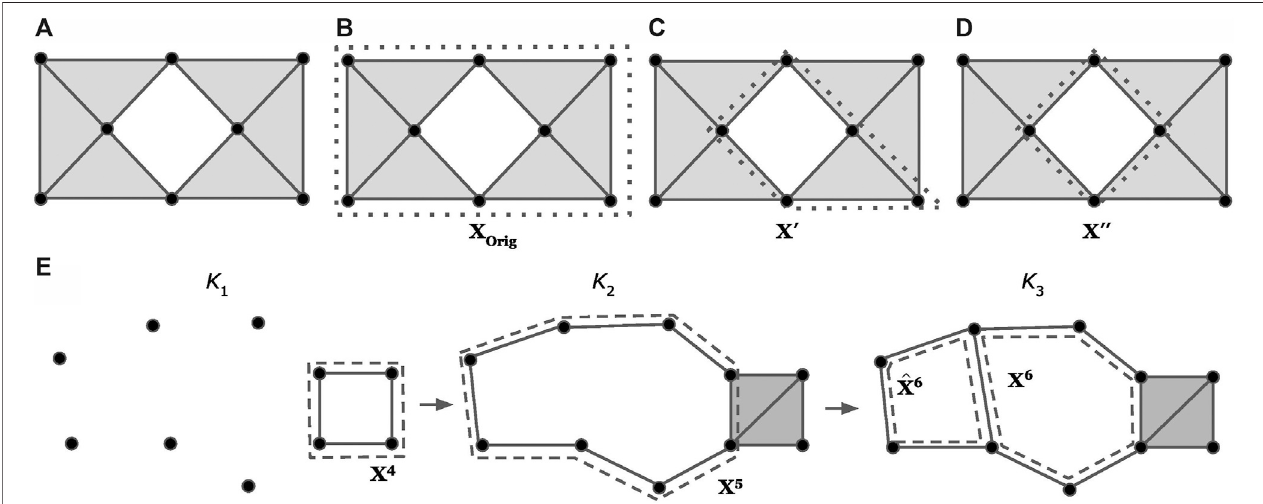
FIGURE 3 | Examples of optimizing a cycle representative (using the notion of minimizing edges) within the same homology class (A-D) and using a basis of cycle representatives (E) , modi fi ed examples adapted from (Escolar and Hiraoka, 2016; Obayashi, 2018). The dotted lines represent a cycle representative for the enclosed “ hole. ” Intuitively, we consider x ′′ in (D) as the optimal cycle representative since it consists of the smallest number of edges. Sub fi gure (E) shows a case where we optimize a cycle representative using a basis of cycle representatives. In (E) , { x 4 , x 5 , x 6 } is the original basis of cycle representatives. We can substitute x 6 with (cid:9) x 6 , which we can obtain by adding x 5 to x 6 , and thus obtain { x 4 , x 5 , (cid:9) x 6 } as the new basis of cycle